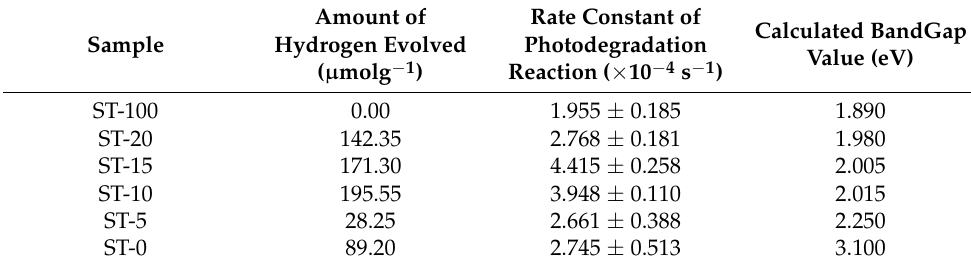
Table 2. Comparison of the amount of hydrogen evolved and rate constant of the degradation reaction of MB by using pure SnS 2 , TiO 2 , and SnS 2 -embedded TiO 2 nanocomposite over simulated irradiation with the bandgap of these